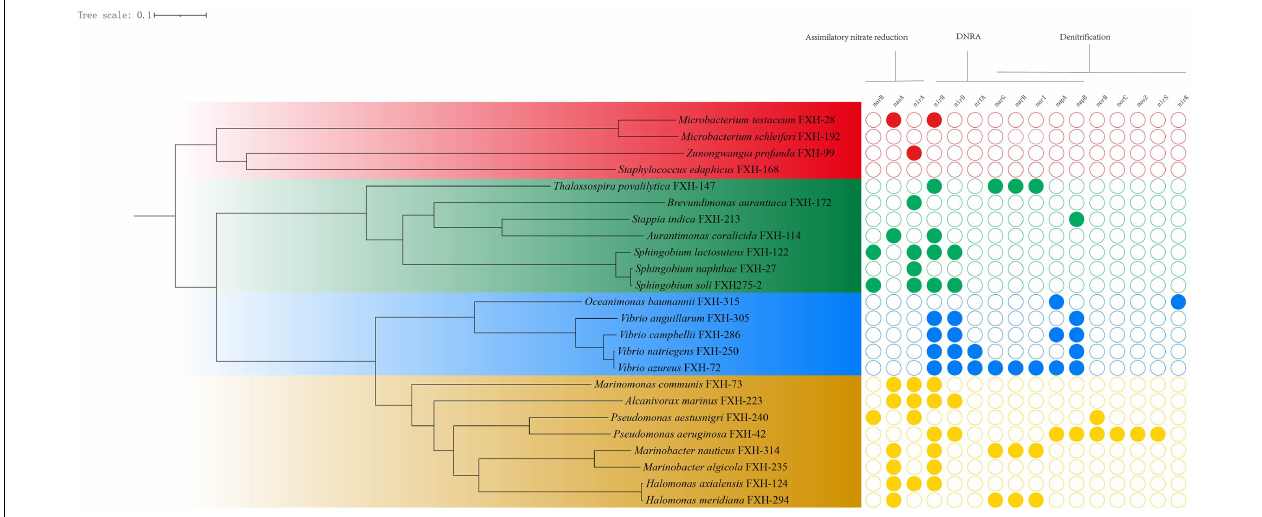
FIGURE 2 | The genomic phylogenetic tree of representative isolates and corresponding genes involved in nitrogen